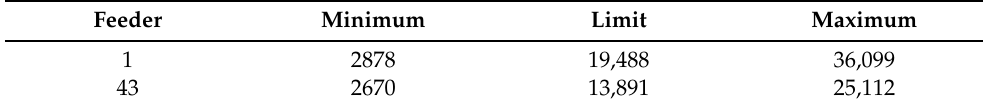
Table 3. EIDCU of the 43-bar